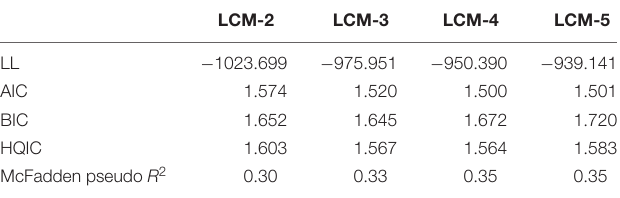
TABLE 4 | Latent class model